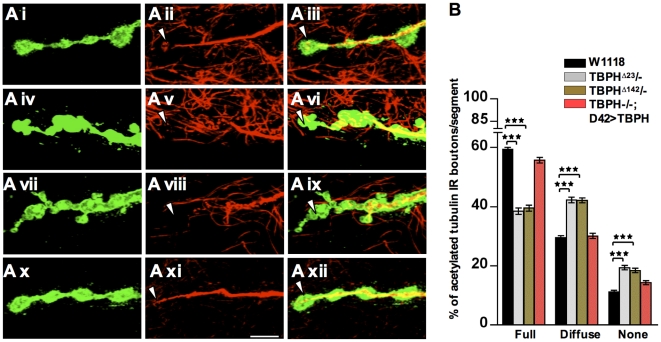
Reduced stable MT and Tubulin acetylation in TBPH mutants.(A) Confocal images showing wild type boutons with stable MT bundles (Ai–Aiii, arrowhead) labeled by acetylated Tubulin. TBPH mutants (Aiv–Avi) TBPHD23/-, (Avii–Aix) TBPHD142/- show the absence of acetylated MTs staining at the distal boutons (arrowhead). (Ax–Axii) D42-GAL4 driven TBPH expression rescues the lack of stable MTs in the TBPH loss of function. Scale bar 5 µm. (B) Quantifications of stable MT labeled by acetylated Tubulin in the abdominal segment II showing significant labeling reduction in TBPH mutant alleles compared to wild type larval NMJ. ***p<0.001 calculated by one-way ANOVA. n = 16 larvae.